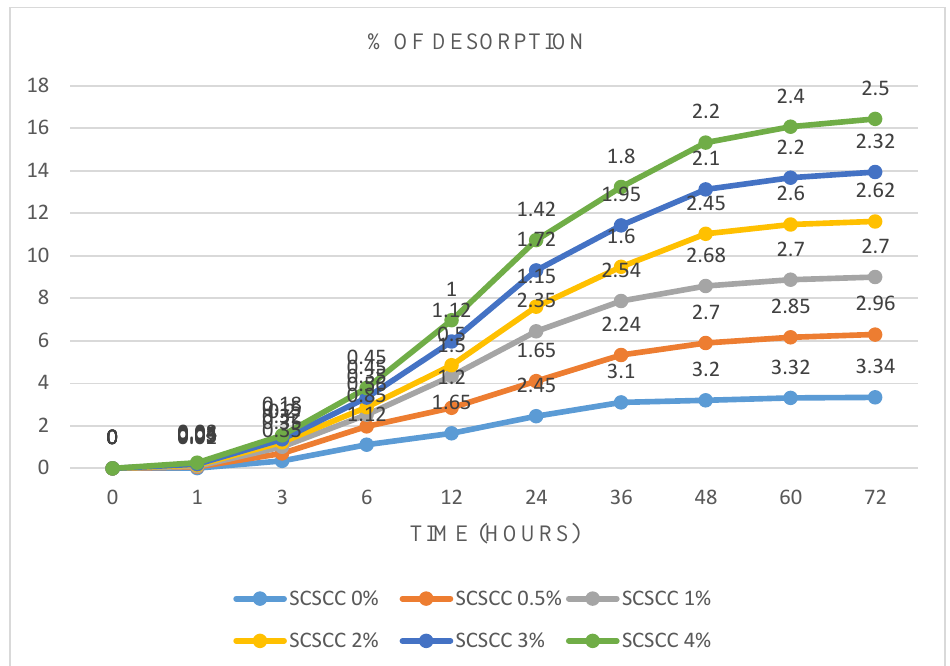
Fig. 31. Results of % of Desorption for SCSCC mixes.